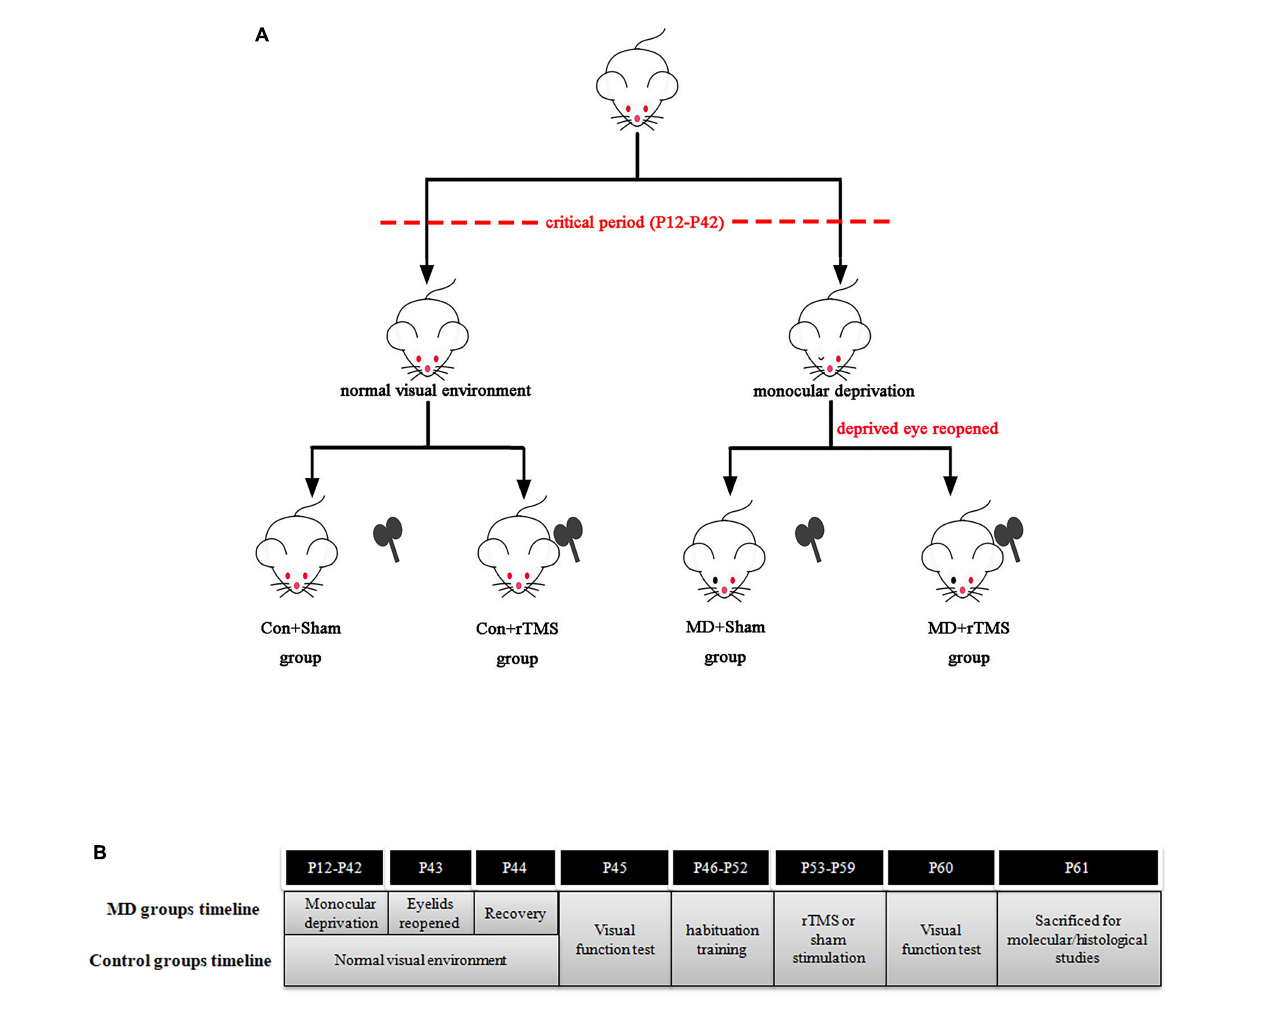
FIGURE1 (A) The four groups in this study. (B) Timelines of monocular deprivation (MD) groups and control